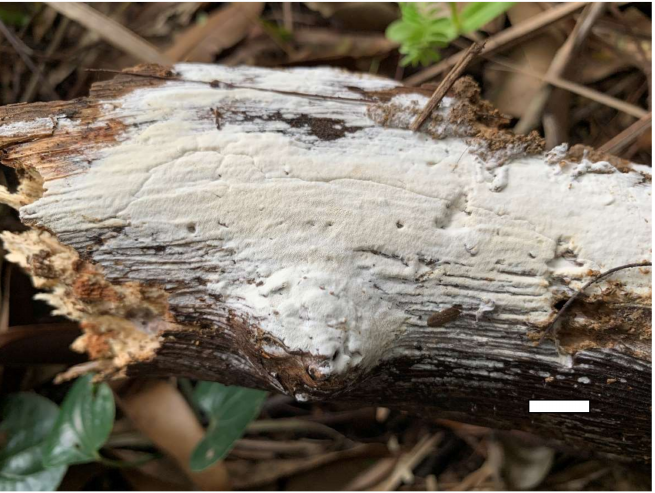
Figure 8. A basidioma of Sidera punctata (from the holotype Dai 22119). Scale bar = 10 mm.